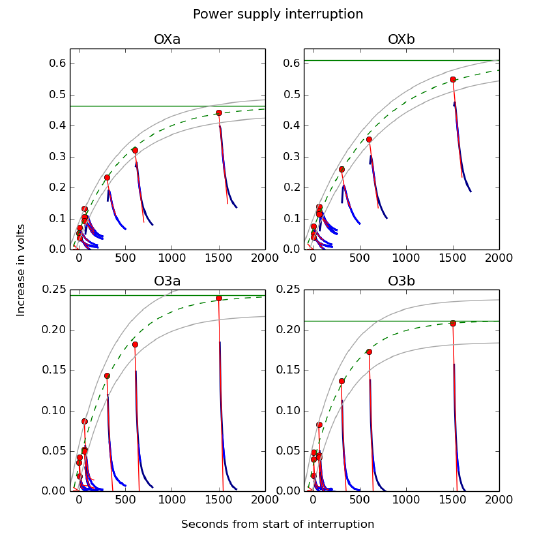
Figure 15. Fitted curves after power supply interruption for four different sensors, two each of oxidising (OXa and OXb) and ozone (O3a and O3b), mounted in the same enclosure. The blue curves are the time-shifted raw voltage curves; the red lines are hysteresis-compensated voltage curves with points at the time at which the power supply was reconnected; the dashed green line is an exponential curve fitted to these points showing the likely voltage curve when the power is disconnected and the sensor is cooling; and the solid green line is the unpowered baseline voltage inferred from this fit. The grey curves above and below the exponential fit are the 95% confidence interval for